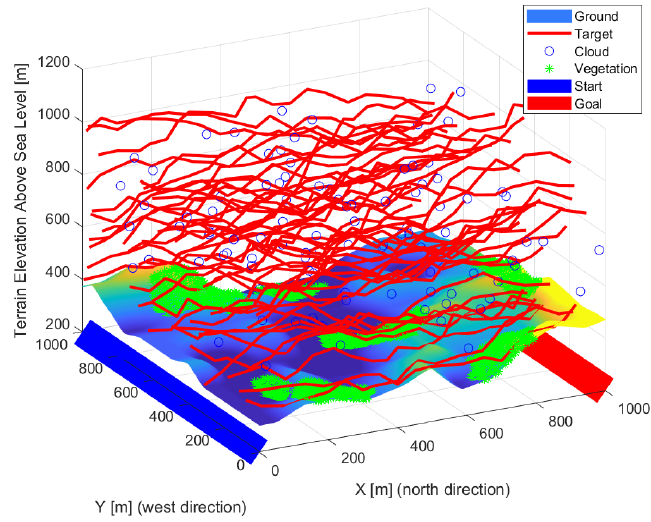
Figure 3. New routes (red lines) were generated at each iteration step.